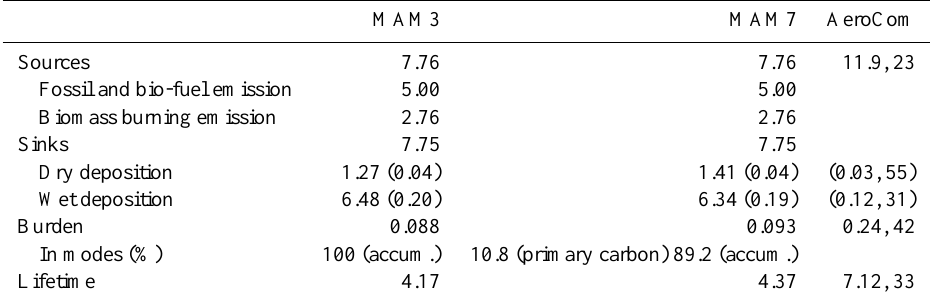
Table 6. Global budgets for BC. The means and normalized standard deviations (in %) from available models participating in AeroCom (Textor et al., 2006) are listed. The values in parentheses are mean removal rates (in day − 1 ), and normalized standard deviations (in %) as budget terms are not given in Textor et al. (2006). For comparison, removal rates (in day − 1 ) from MAM3 and MAM7 are listed in